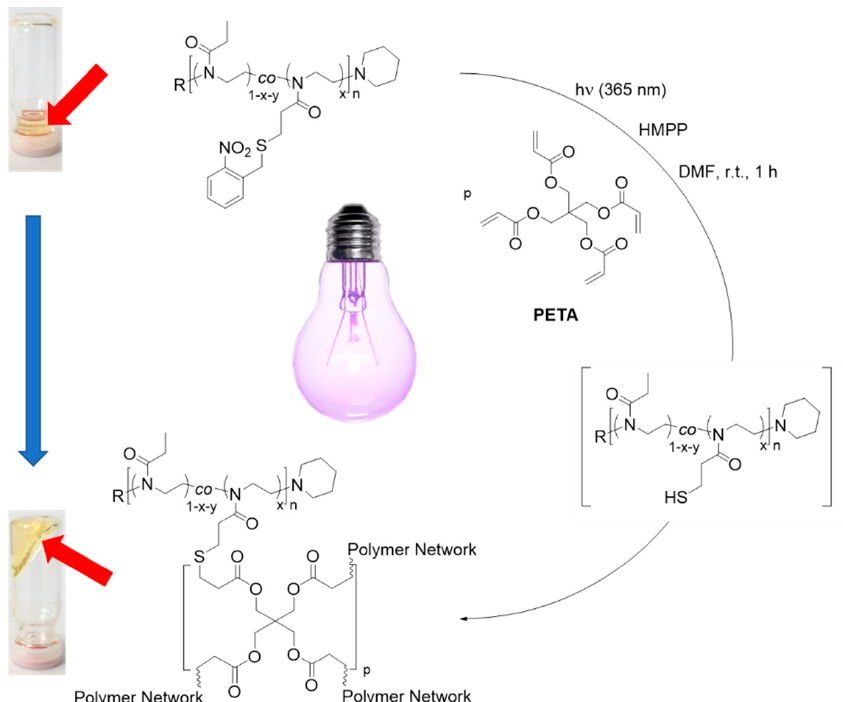
Figure 3. Tandem network formation by in situ photodeprotection and concurrent crosslinking of P10% with pentaerythritol tetraacrylate (PETA). The label R in the polymer structure denotes the initiator EtOxa-homoblock with degree of polymerization y. The photos (left) show the liquid-to-gel transition induced by UV irradiation of the tilted vial resulting in a rigid gel. Red arrows indicate liquid and gel, respectively.